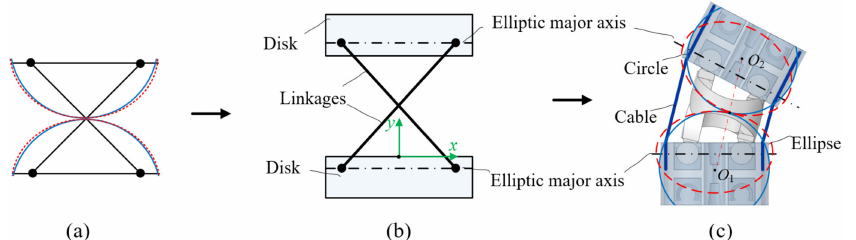
Figure 4. The joint structure design. ( a ) The initial anti-parallelogram mechanism sketch. ( b ) The initial joint sketch. ( c ) The joint design with anti-parallelogram